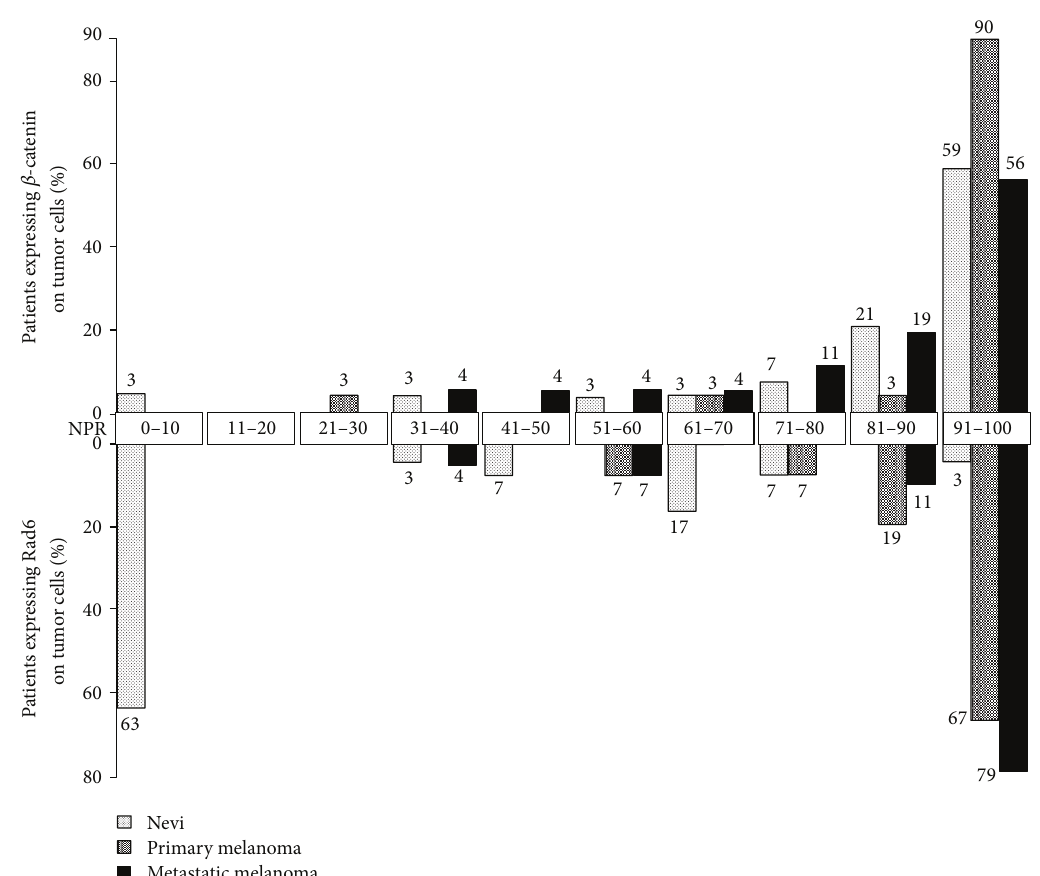
Figure 2: Percentages of nevi, primary melanomas, and metastatic melanomas with Rad6 and 𝛽 -catenin positive cells shown in increments of 10 percentage